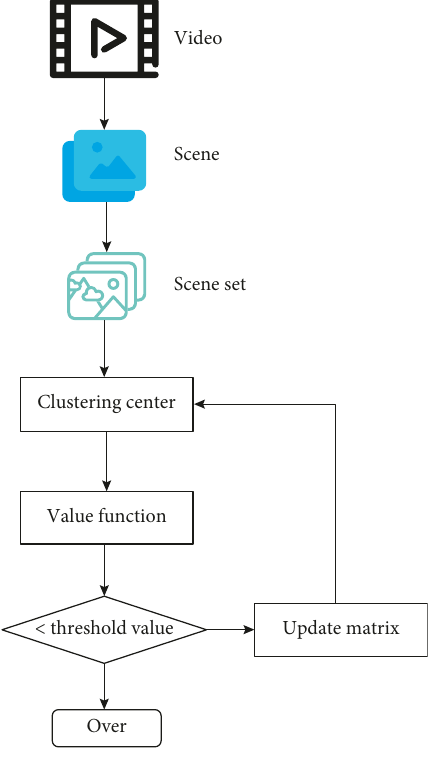
Figure 2: Key frame extraction